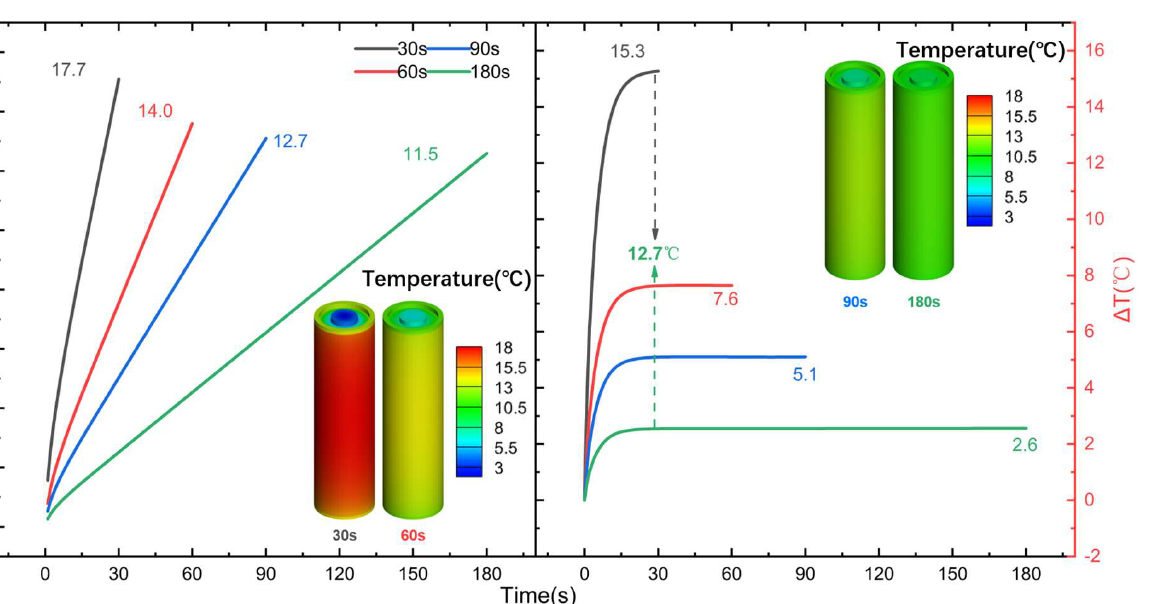
Figure 15. Temperature distribution in the radial direction inside the cell. Heating for ( a ) 30 s; ( b ) 60 s; ( c ) 90 s; ( d ) 180 s. 3.5. MSP Heating Protocols for HF In practice, a temperature measurement point is usually placed at the axial midpoint of a cylindrical cell, and the monitored temperature represents the average temperature of the cell. However, with high-power heating, when the temperature of the monitoring point is close to the pre-set temperature, even if the heating is halted immediately, the temperature at the monitoring point will still have a rising ‘inertia’, making it tough to accurately end the temperature at the set temperature. This chapter offers a multi-stage stepped power (MSP) heating protocol that permits the HF to progressively decrease the